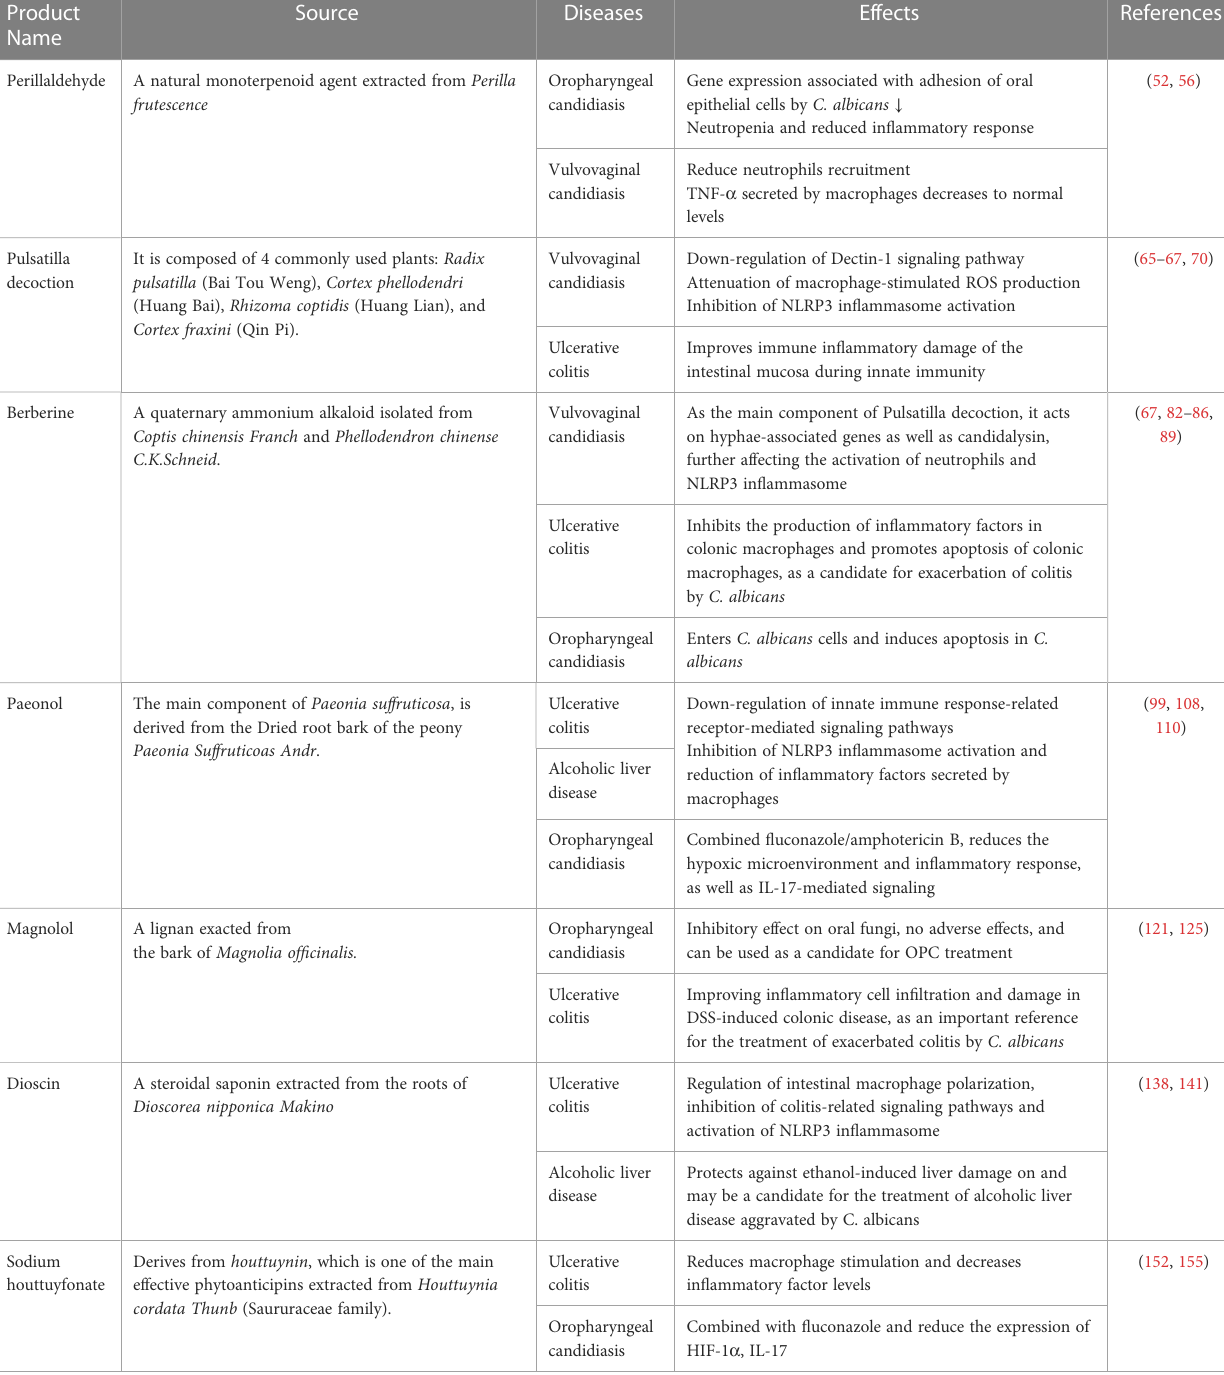
TABLE 1 Sources of Chinese herbal medicine and their effects on C. albicans -related